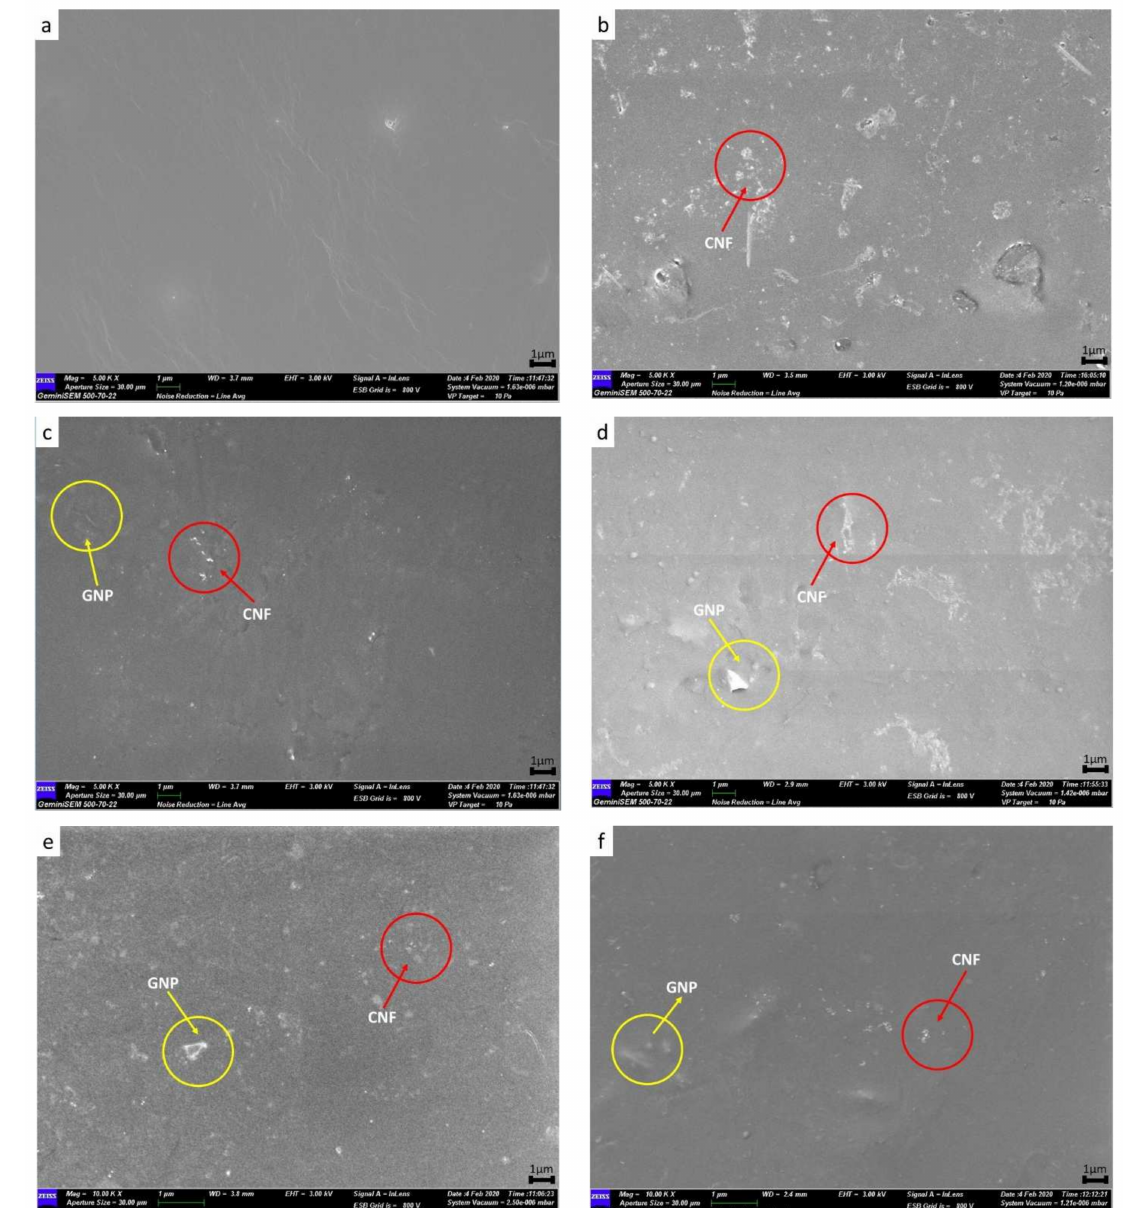
Figure 4. FESEM image of: ( a ) WBPU; ( b ) WBPU-0; ( c ) WBPU-0.5; ( d ) WBPU-1.0; ( e ) WBPU-1.5; ( f )